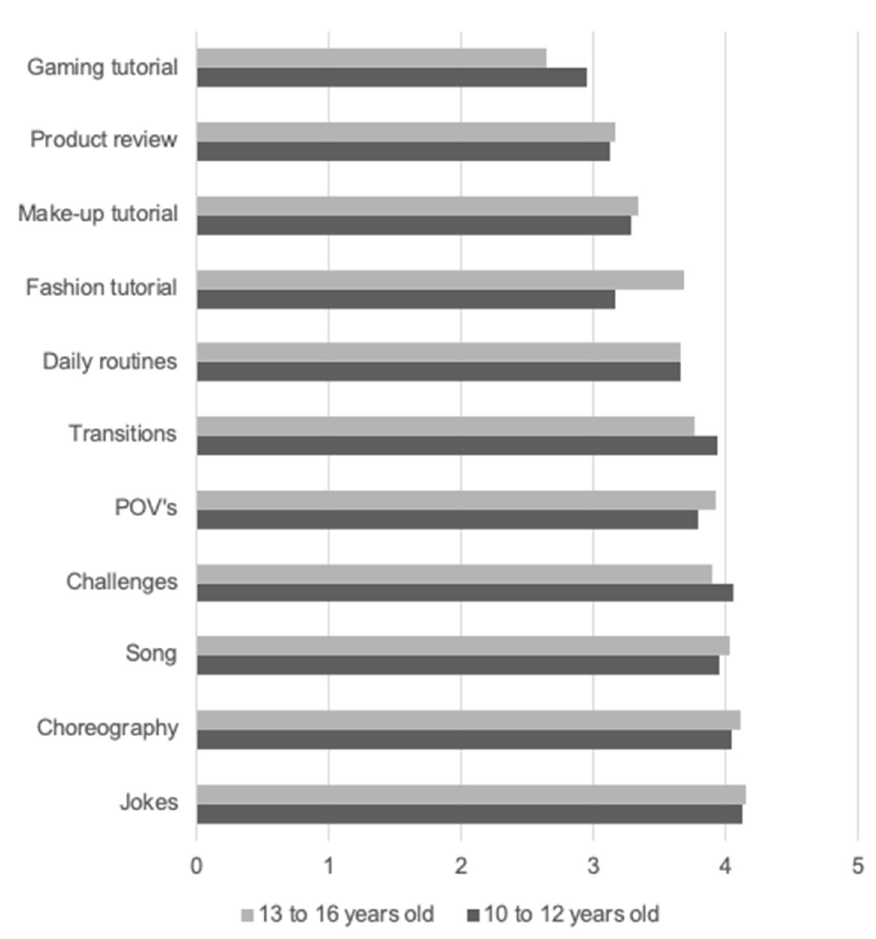
Figure 5. Respondents who enjoy different types of TikTok content (in percentage).